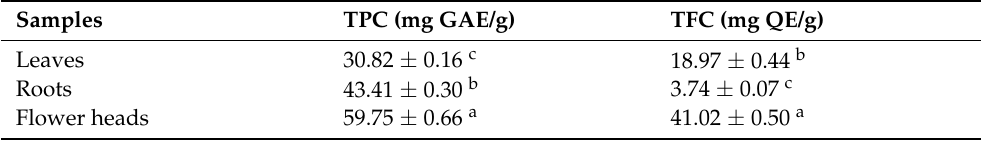
Table 1. Total phenolic and flavonoid contents of the T. balsamita